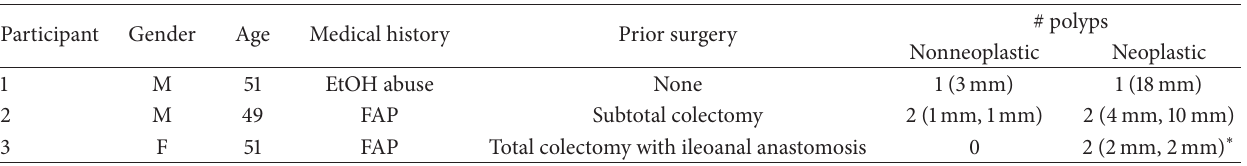
Table 1: Demographics of trial participants. ∗ The polyps seen in Participant 3 were only visualized on conventional endoscopy and not on experimental endoscopy.